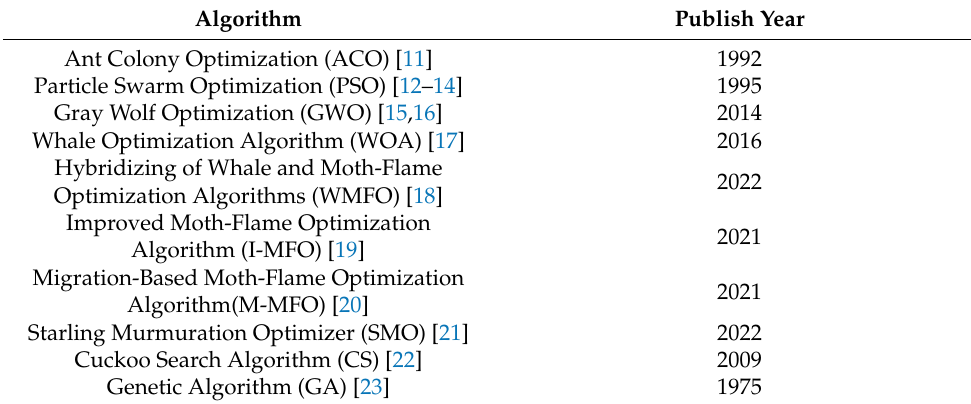
Table 1. Some related intelligent optimization